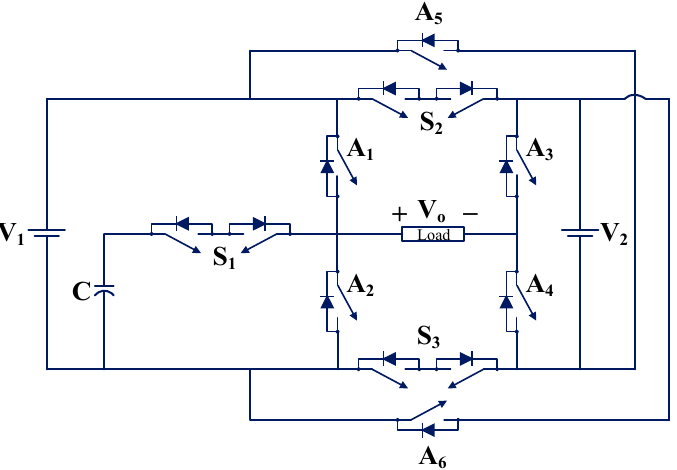
Figure 17. Single-phase nine-level FT MLI (TP18) [40].